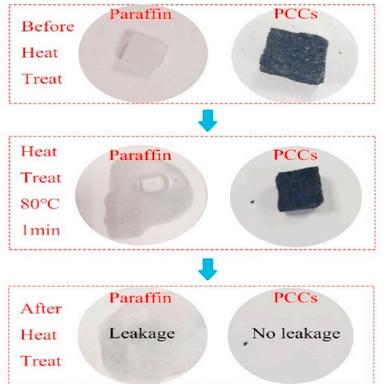
Thermal cycling test of PCCs.